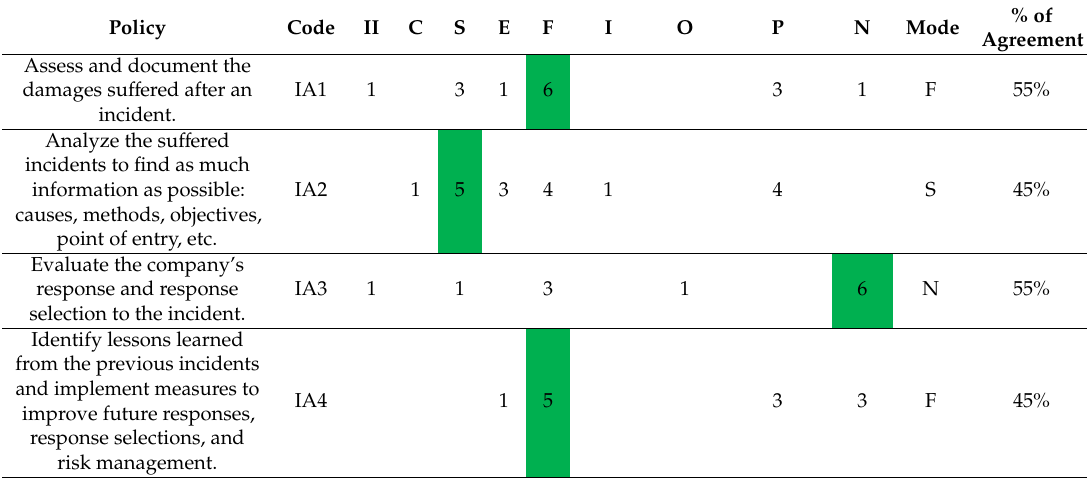
Table 15. Incident analysis policies’ progression